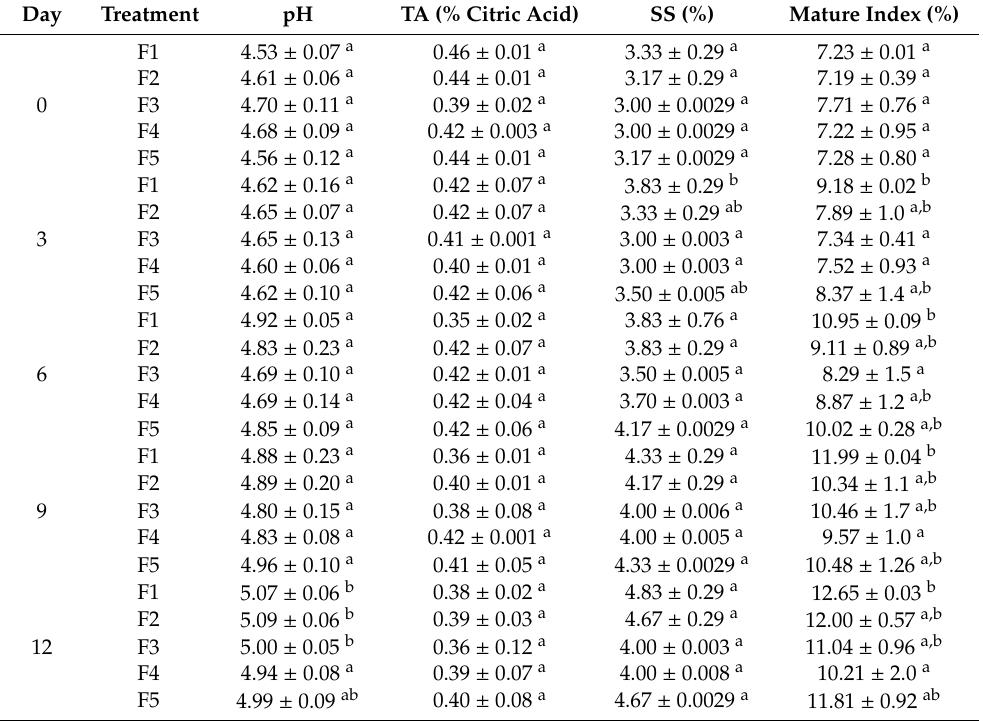
Table 2. Physical–chemical characteristic in S. lycopersicum with CS + RGEO coatings stored for 12 days at 4 ± 2 ◦ C. F1 = Control; F2 = CS; F3 = CS + RGEO 0.5%; F4 = CS + RGEO 1.0%; F5 = CS + RGEO 1.5%. Mean values and intervals of LSD 95% according to the analysis of